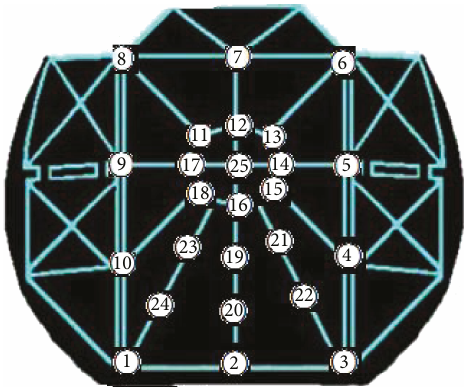
Figure 2: Distribution of piezoelectric ceramic actuators on the middle re fl ector of the 5 m deployable